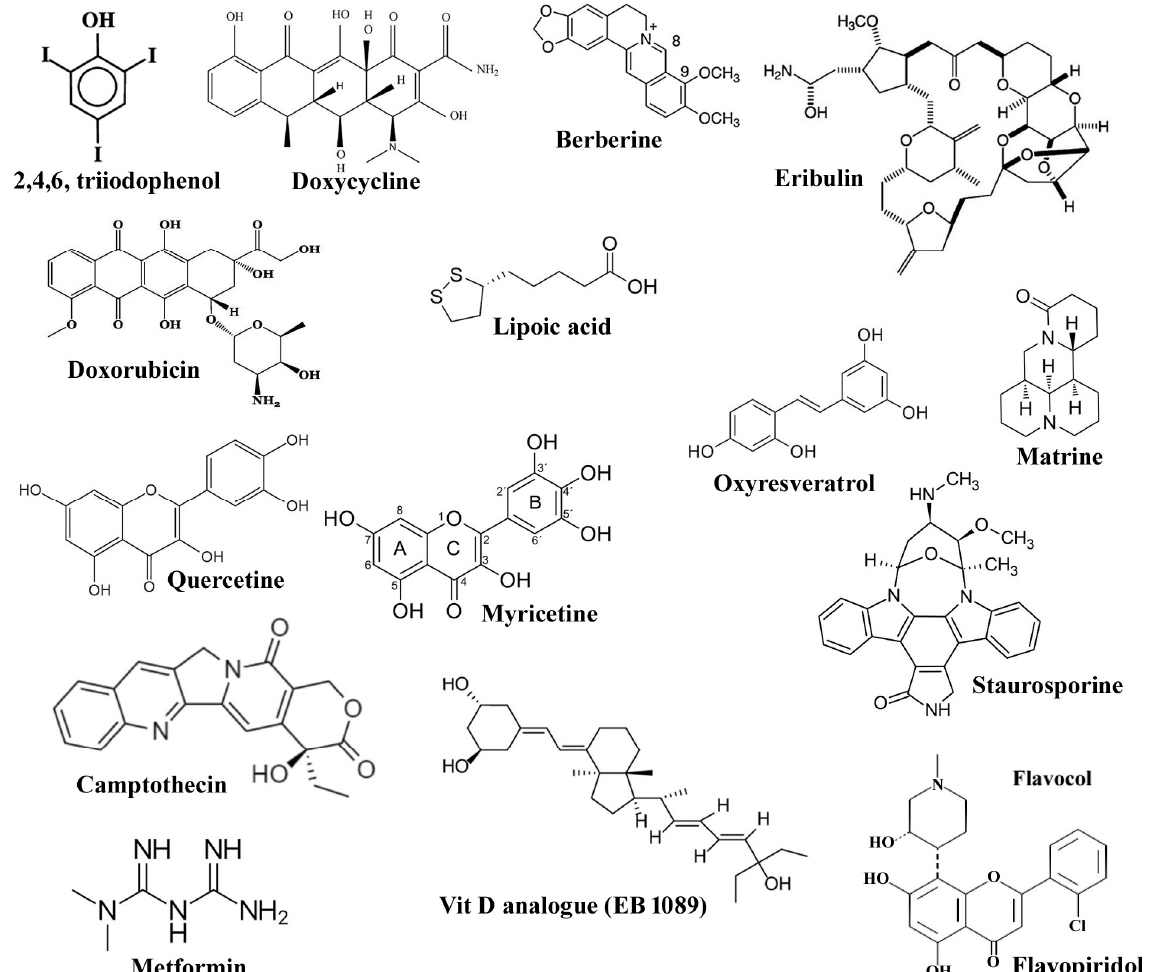
Figure 3. Chemical structures of molecules inducing caspase-independent cell death. Table 1. Overview of inducing agents engaged in caspase-independent programmed cell death. Classification